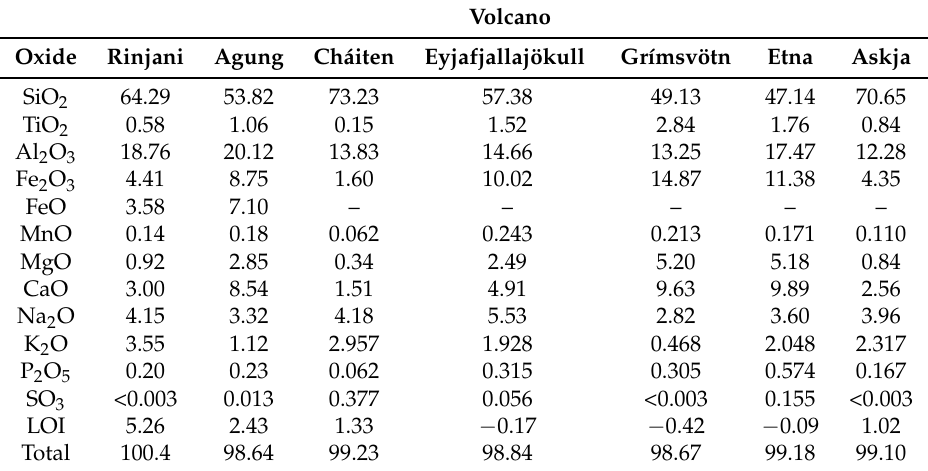
Table 3. Composition of ash from some recent volcanic